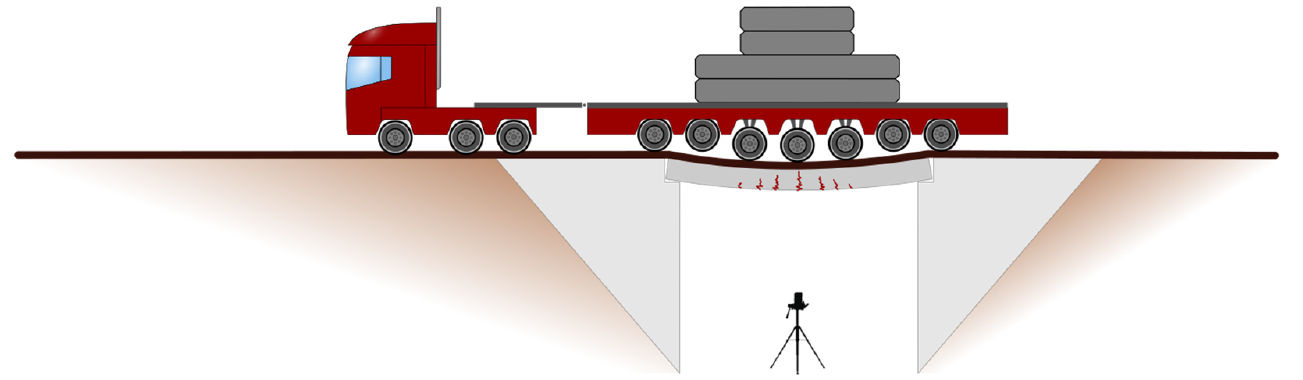
Figure 2. Bridge loading with a special vehicle while being monitored via 2D DIC.